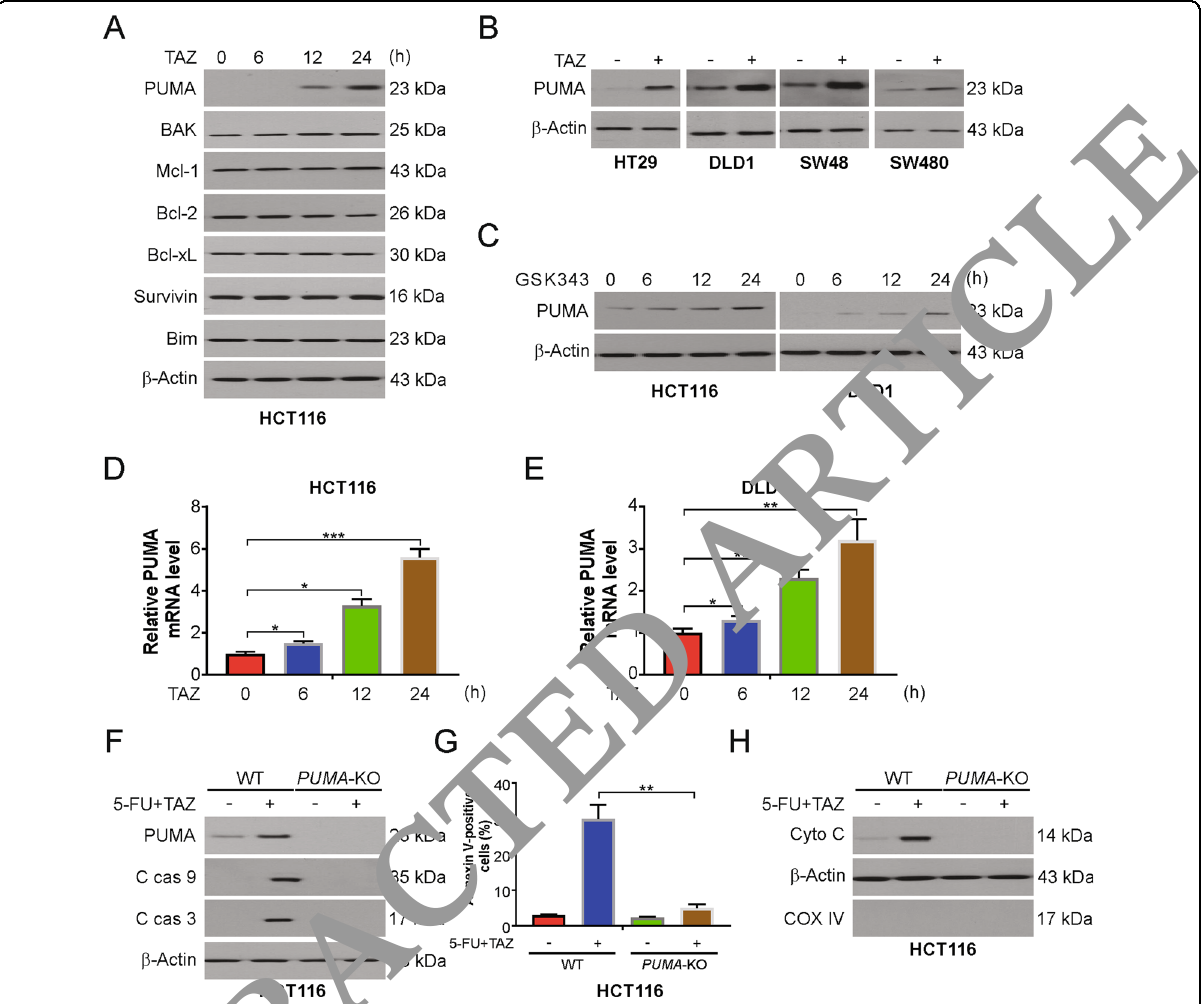
Fig. 3 PUMA is required for tazemetostat/5-FU-induced apoptosis. A HCT116 cells were treated with 0.5 μ M tazemetostat at indicated time points. Indicated proteins were analyzed by western blotting. B Indicated cell lines were treated with 0.5 μ M tazemetostat for 24 h. PUMA expression was analyzed by western blotting. C HCT116 or DLD1 cells were treated with 1 μ M GSK343 at indicated time points. PUMA expression was analyzed by western blotting. D HCT116 cells were treated with 0.5 μ M tazemetostat at indicated time points. mRNA level of PUMA was analyzed by real-time PCR. E DLD1 cells were treated with 0.5 μ M tazemetostat at indicated time points. mRNA level of PUMA was analyzed by real-time PCR. F WT and PUMA -KO HCT116 cells were treated with the combination of 2.5 μ g/mL 5-FU and 0.5 μ M tazemetostat for 24 h. Indicated proteins were analyzed by western blotting. G WT and PUMA -KO HCT116 cells were treated with the combination of 2.5 μ g/mL 5-FU and 0.5 μ M tazemetostat for 24 h. Apoptosis was analyzed by fl ow cytometry. H Cytosolic fractions isolated from WT and PUMA -KO HCT116 cells treated with the combination of 2.5 μ g/mL 5-FU and 0.5 μ M tazemetostat for 24 h were probed for cytochrome c by western blotting. β -actin and cytochrome oxidase subunit IV